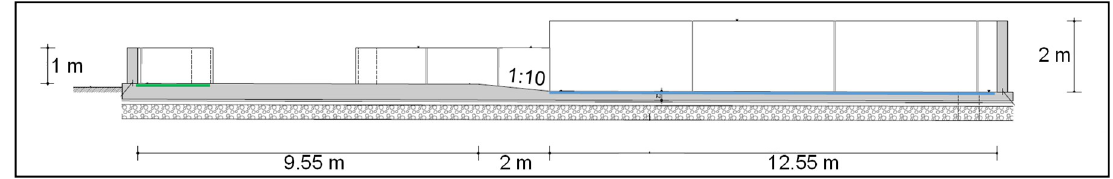
Figure 2. Profile of the outdoor wave basin with wave maker position (green) and deep section (blue).